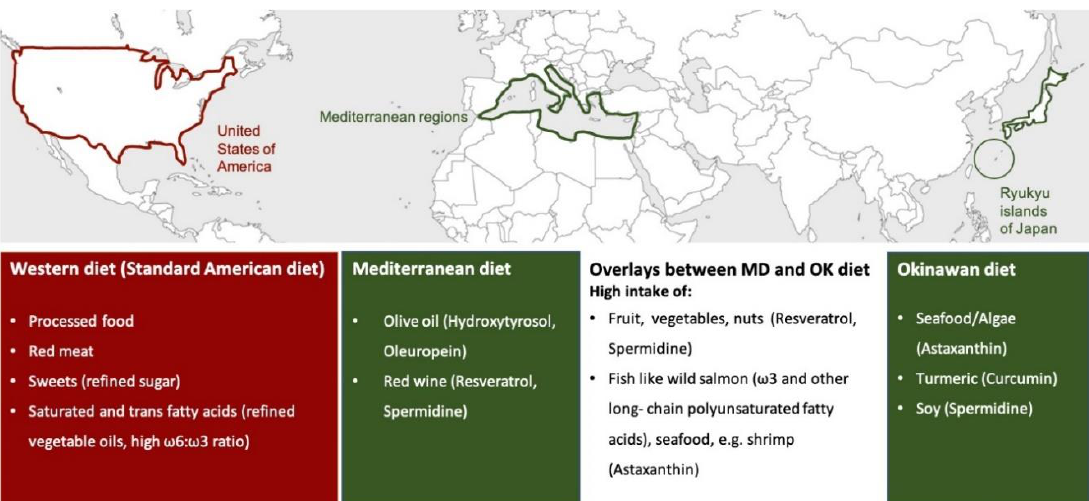
Figure 1. Characteristic bioactive compounds of the Mediterranean and Asian/Okinawan diet. The figure shows the geographic origin of three different types of diets: the Western, the Mediterranean, and the Asian (Okinawan) diet. The Mediterranean diet is defined as a dietary pattern of people living in countries that border the Mediterranean Sea, whereas the Okinawan diet originates from the eating habits of the indigenous people of the Japanese Ryukyu Islands (main island Okinawa). The Western diet is prevalent in developed countries, especially in the USA. Typical of the Mediterranean diet is the consumption of red wine with its active ingredients resveratrol and spermidine, and the intake of olive oil with its active ingredients oleuropein and hydroxytyrosol. All four compounds are associated with beneficial effects on human health. Characteristic food items of the Okinawan diet that are also known for their health benefits are soy products such as tofu (spermidine), turmeric (curcumin), seafood, and algae (astaxanthin). Similarities of both diets include the intake of a broad spectrum of antioxidants, polyphenols (like resveratrol), and spermidine from fruit and vegetable and the moderate-to-high consumption of seafood and fish (astaxanthin, healthy fatty acids). In contrast to both diets, the Western diet could have detrimental health consequences due to the high consumption of unhealthy fatty acids (saturated fatty acids), red meat, sweets, and highly processed food items. Abbreviations: MD = Mediterranean diet, OK = Okinawan diet, ω = omega, USA = United States of America.